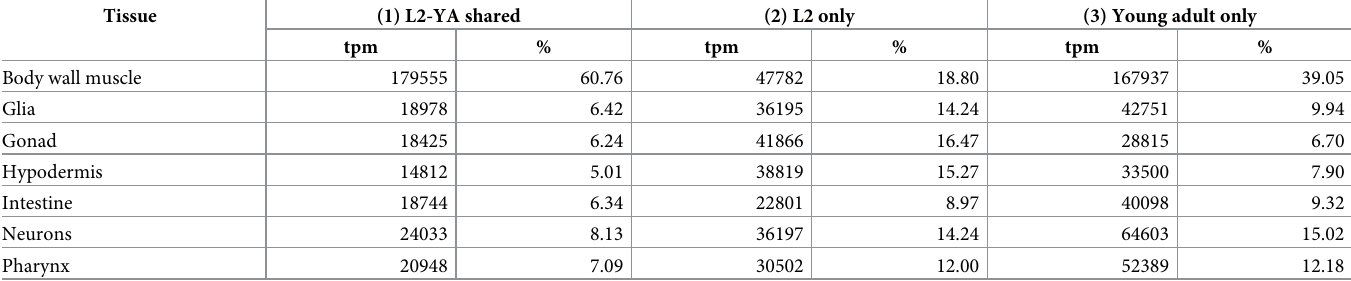
Table 2. Distribution of expression levels over tissues for CEH-60 gene targets identified by DamID present in both L2 and Young Adult (YA) datasets, L2 only or YA only, according to L2-stage single-cell RNA-seq analysis of [35].